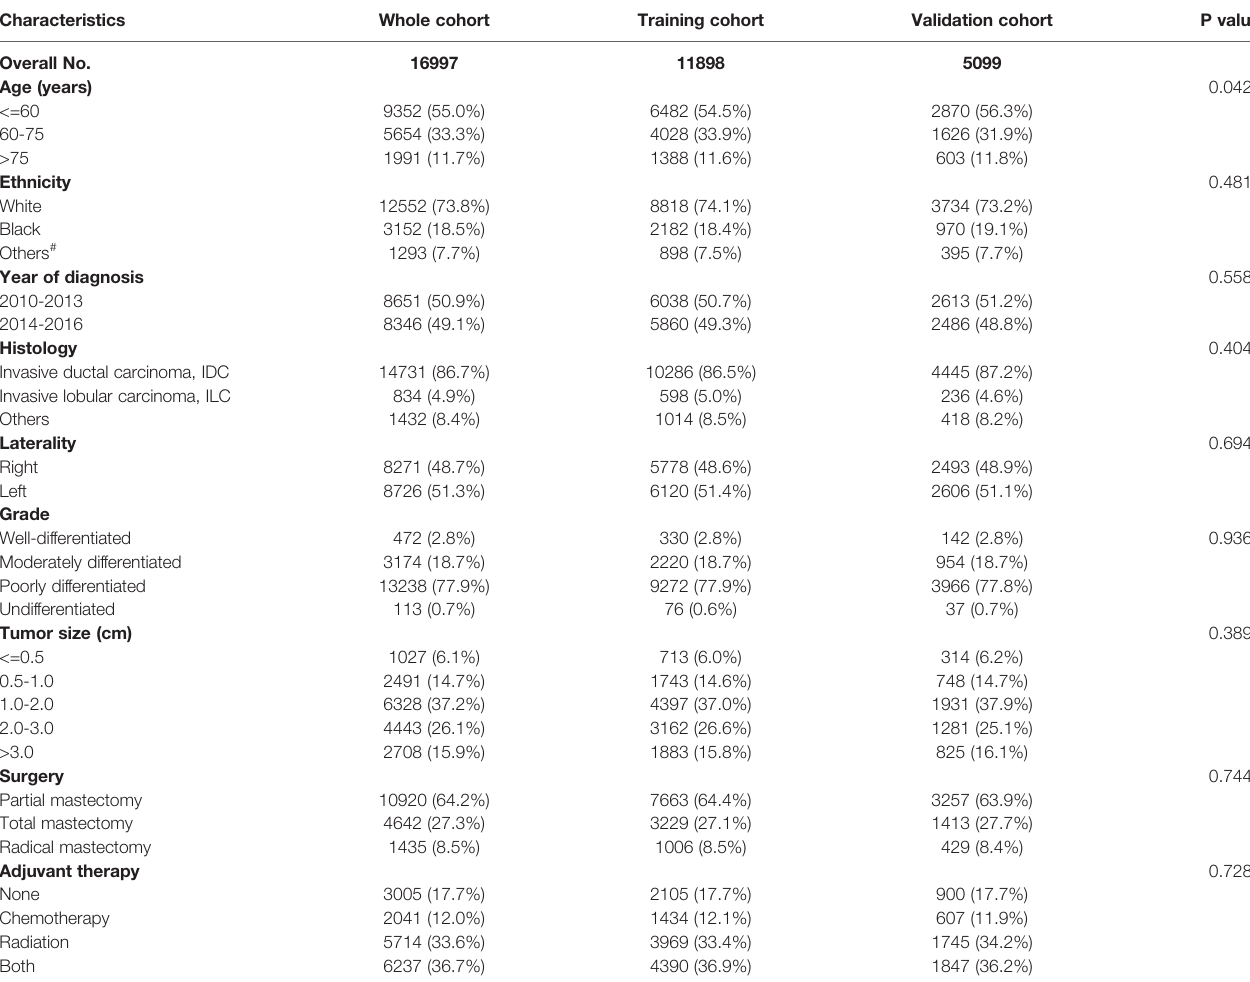
TABLE 1 | Demographics and clinicopathological characteristics of patients with pT1-pT2N0M0 triple-negative breast cancer.